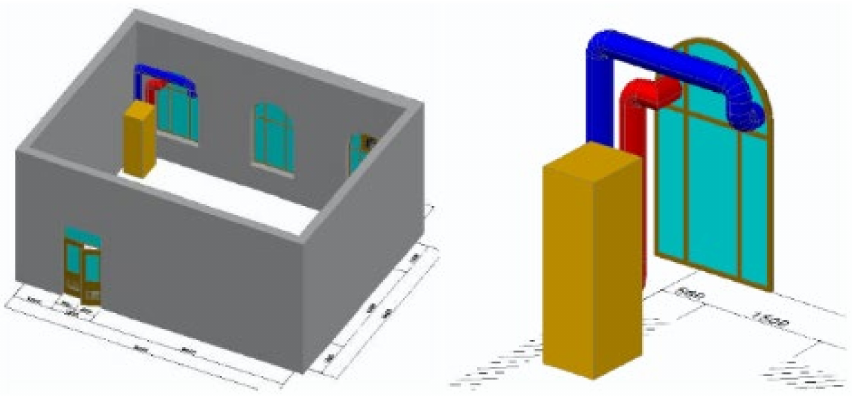
Figure 9. Model of HVAC system with DCV ventilation including fault injector analyzed in